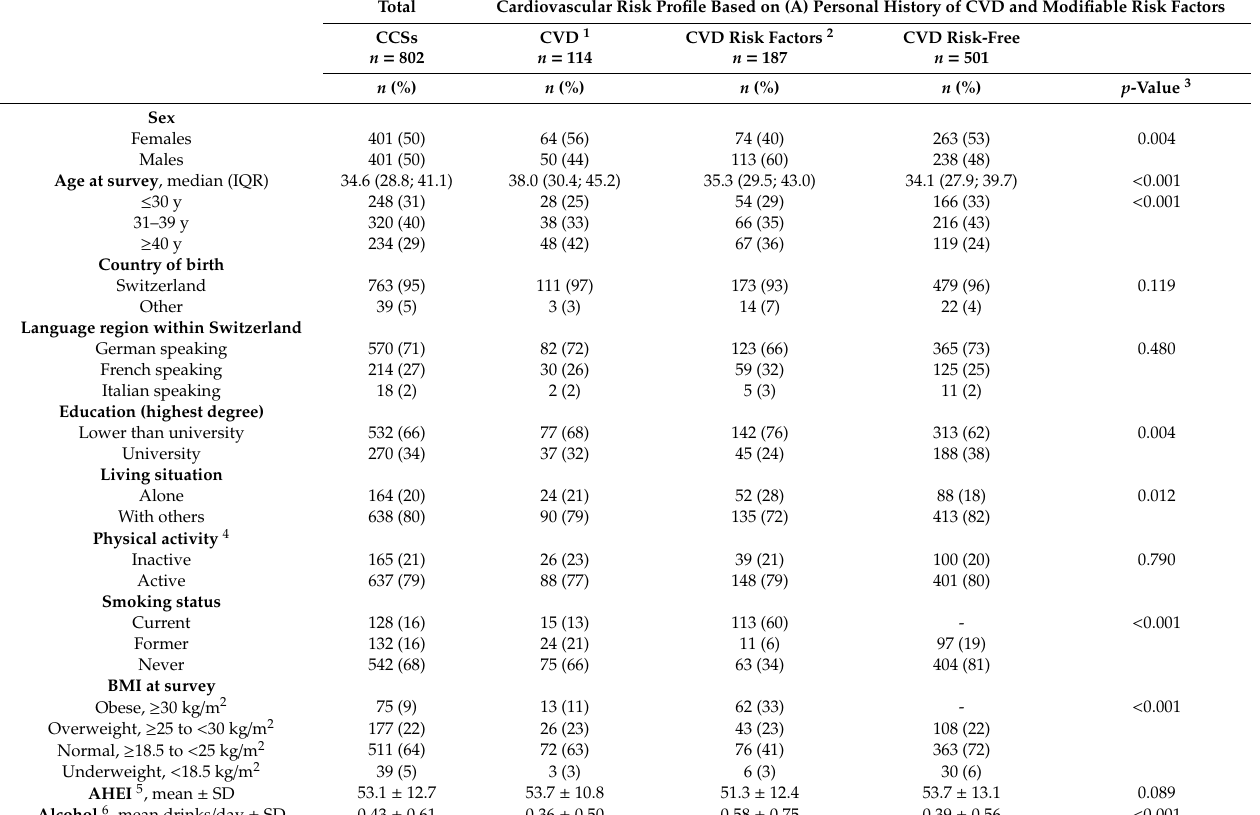
Table 1. Sociodemographic and lifestyle characteristics of adult childhood cancer survivors (CCSs) by cardiovascular risk profile (A).